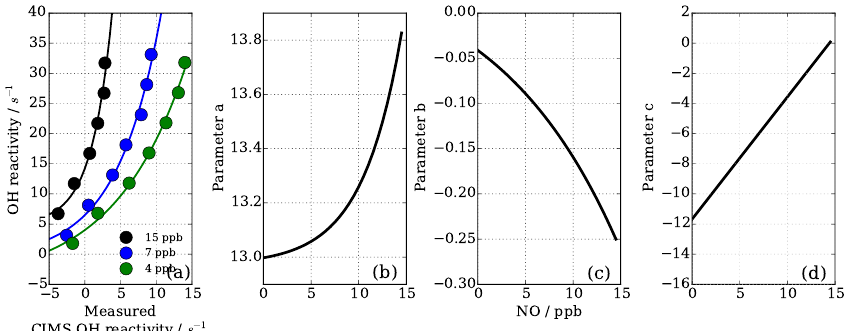
Figure 9. NO − HO x recycling interference on CIMS OH reactivity both dependent on OH reactivity and NO concentration (a) . Functions of parameters (Eq. 7) are dependent on NO concentration (panels b–d correspond to Eqs. 8, 9, 10).